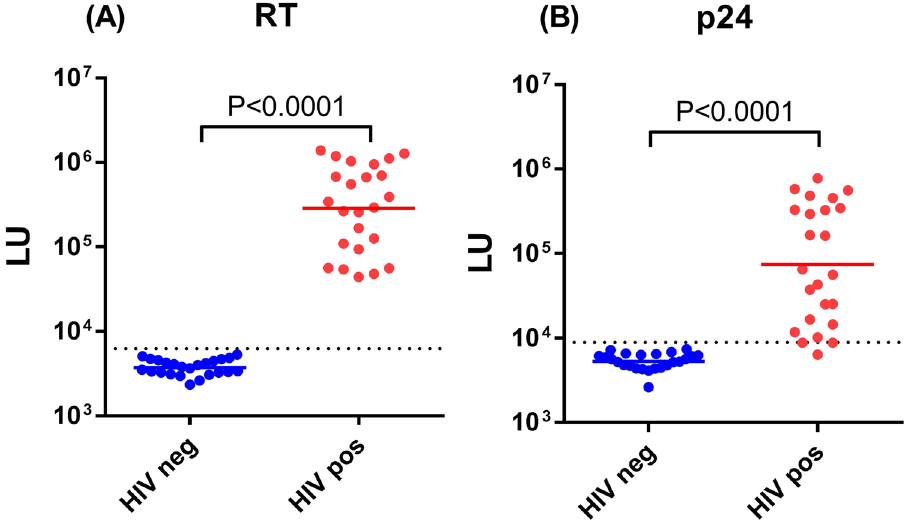
Figure 3. Ultrarapid Diagnosis of HIV. ( A ) HIV reverse transcriptase luciferase protein extract was used for LIPSTICKS antibody measurements with a cohort of HIV negative (blue) and HIV positive individuals (red). Each dot represent an individual subject and the geometric mean of the antibody levels in each group is shown by the colored horizontal bar. Based on the cut-off value (denote by the dotted line) for determining seropositivity, the performance of the test shows 100% sensitivity and 100% specificity for HIV diagnosis. P values were calculated using the Mann-Whitney U test. ( B ) Testing the same cohort of HIV negative (blue) and HIV positive individuals (red) with an extract of HIV p24 luciferase fusion protein demonstrated 96% sensitivity and 100% specificity. P values were calculated using the Mann-Whitney U